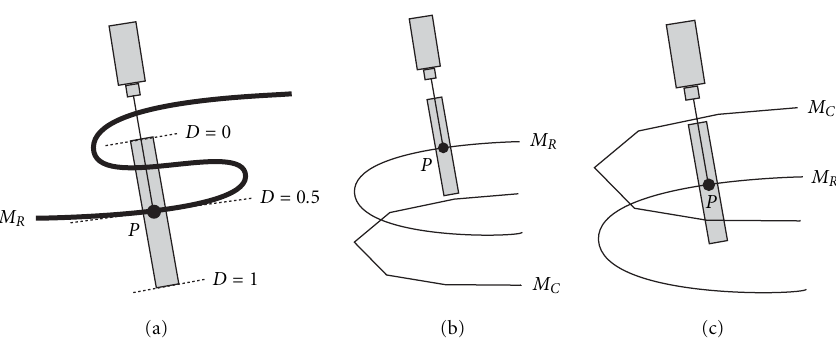
Figure 4: 2D examples of degenerate case with geometric ambiguity. (a) Self-occlusion. (b) No detection (no hit in the view volume). (c) False alarm (wrong hit in the view volume).